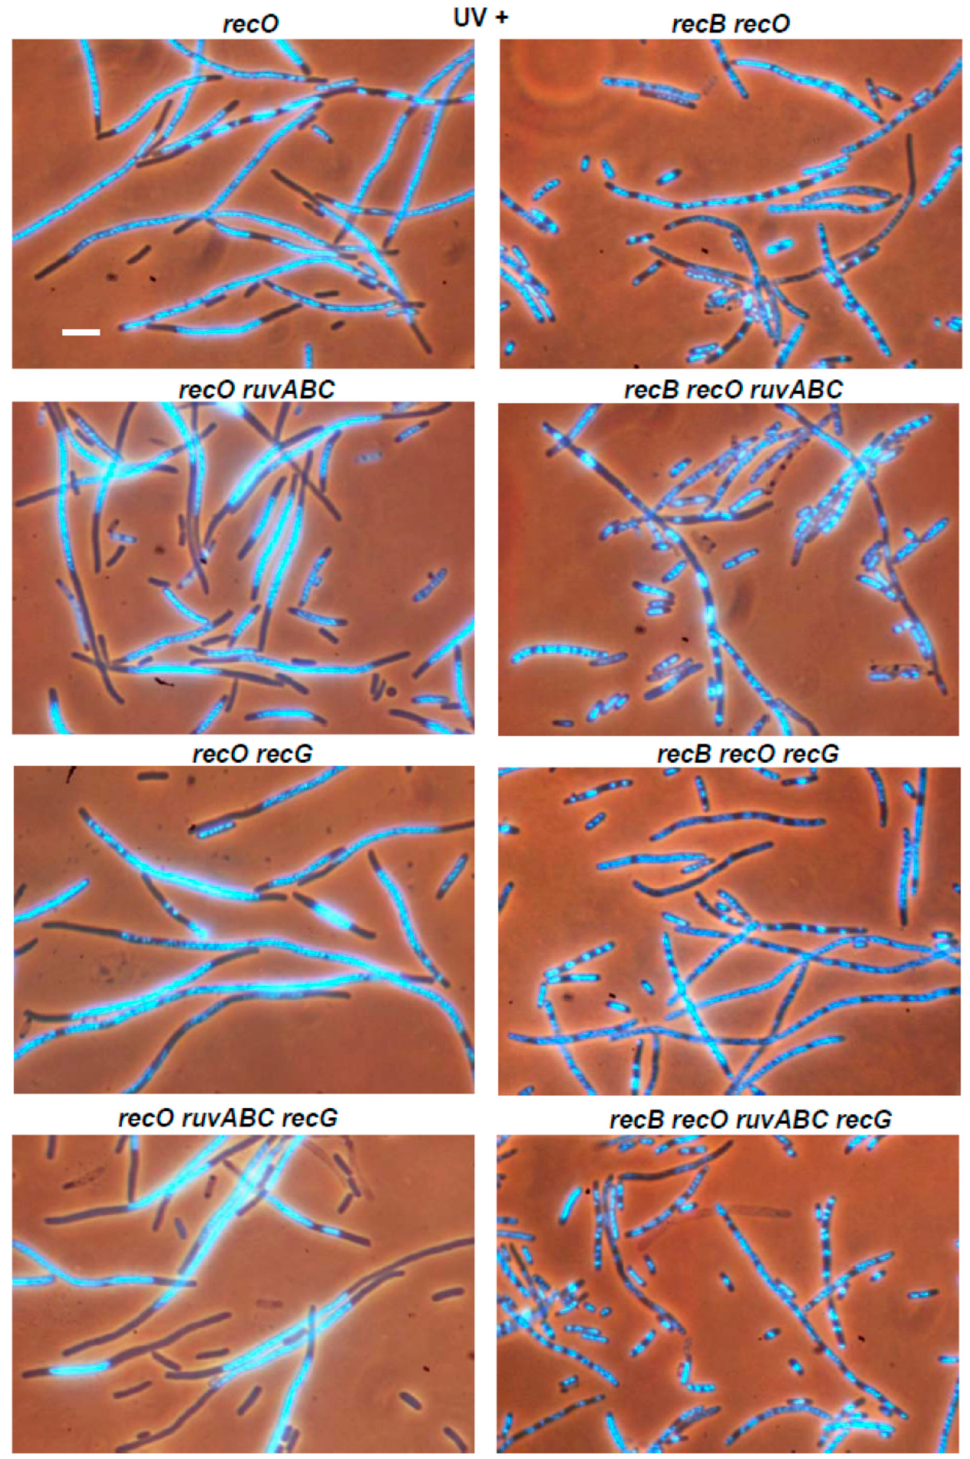
Figure 11. The effects of UV-irradiation on chromosome segregation and cell division in different recombination-deficient mutants of E. coli . Exponential cells were irradiated with 5 J/m 2 of UV light and then further cultured for two hours prior to microscopic analysis. Unirradiated (control) cells are already shown in Figures 6–9. Bar, 5 μ m.